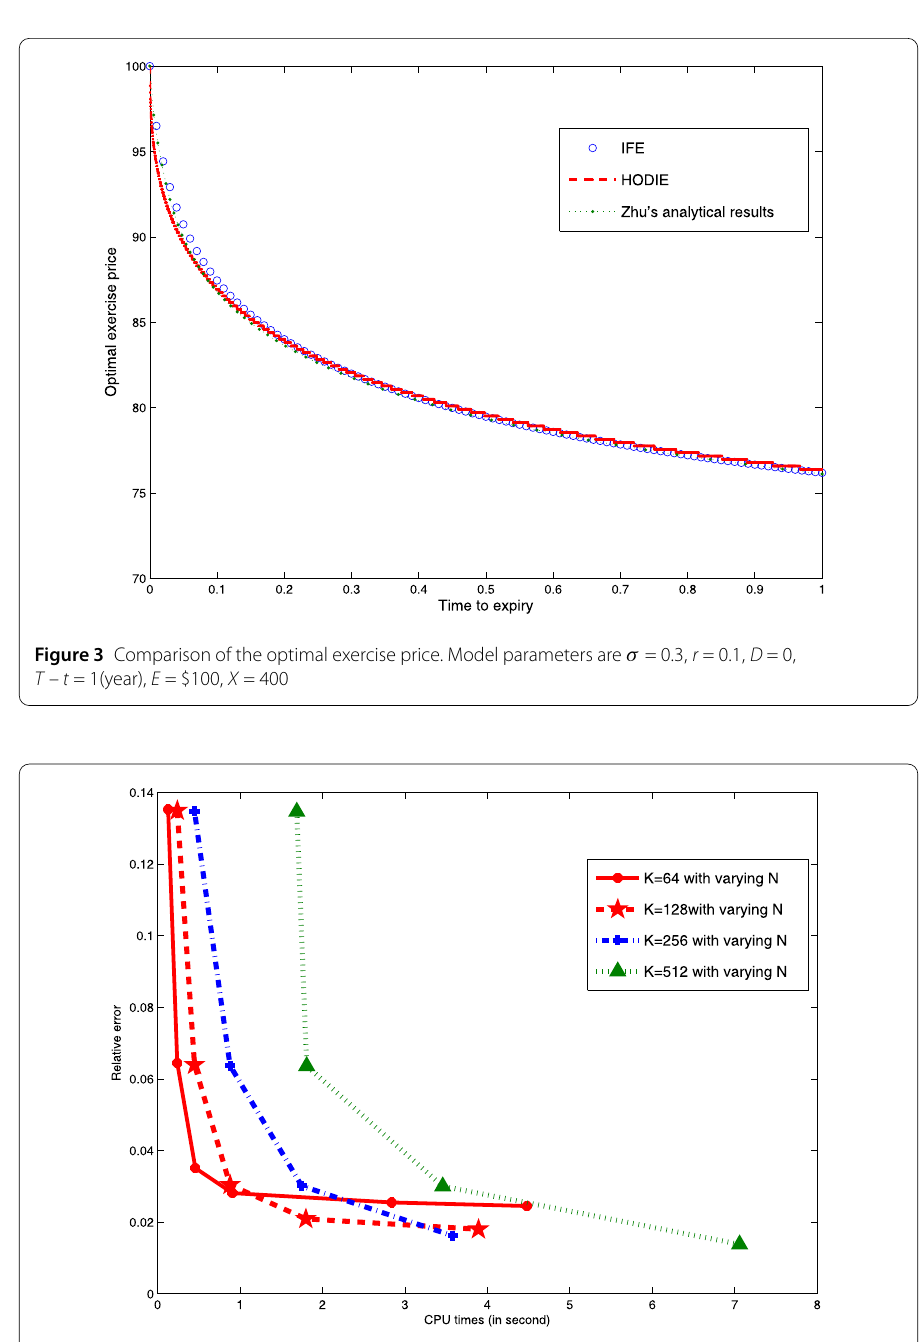
with V and V exact denoting the computed values and the reference values, respectively, and (cid:9)·(cid:9) ∞ being the infinite norm. We remark that the approximate solution calculated on very fine grid sizes, i.e., with N = 4096 and K = 8192, is used as the reference solution here. In this figure, four sets of relative errors with fixed number of time steps are displayed as a function of the varying number of spatial steps and CPU times. All the experiments were performed within Matlab2011b on an Intel(R) Core(TM)i7-2600 CPU, 3.40 GHz